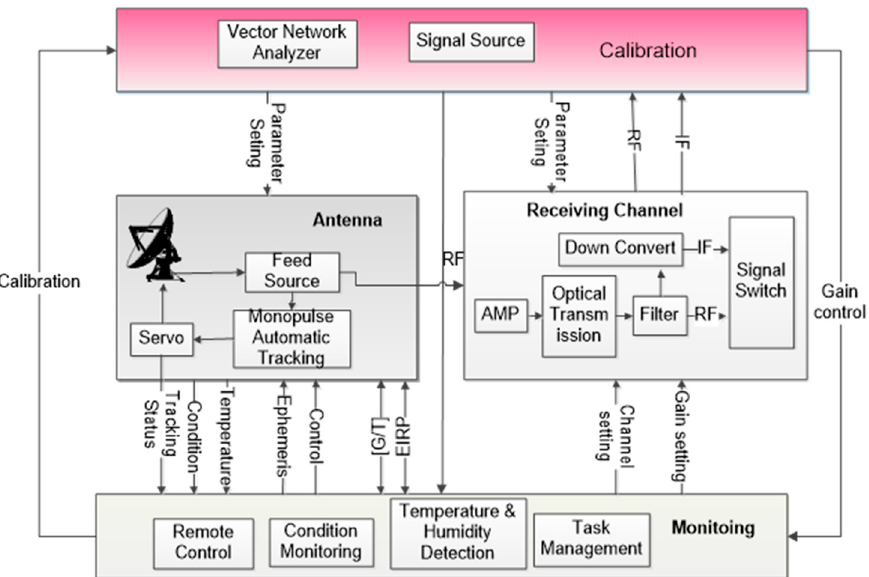
Figure 5. High-gain receiving link of the assessment system. The data collected by the dish antenna using mono-pulse tracking mode is amplified and filtered in the receiving channel. The system has environmental monitoring functions, such as temperature and